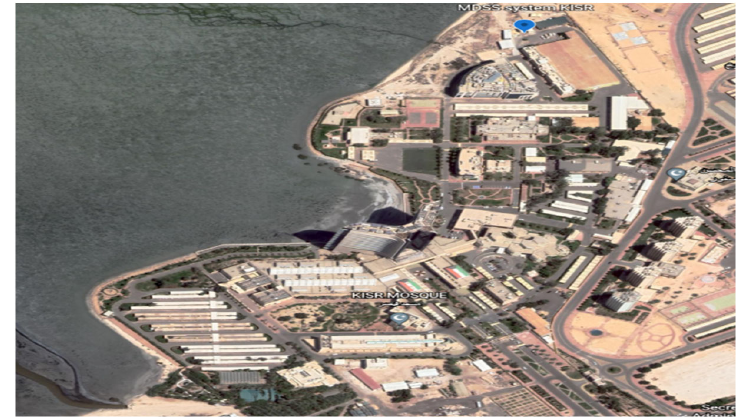
Figure 1. A typical structure of an MSS, with multi ‐ layer condensation channels and an evaporation basin, where product water is collected through the bottom of each channel.